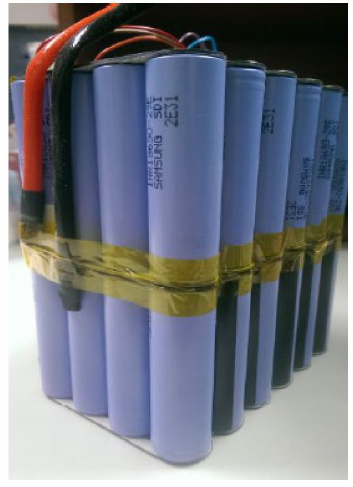
Figure 2. Lithium-ion battery